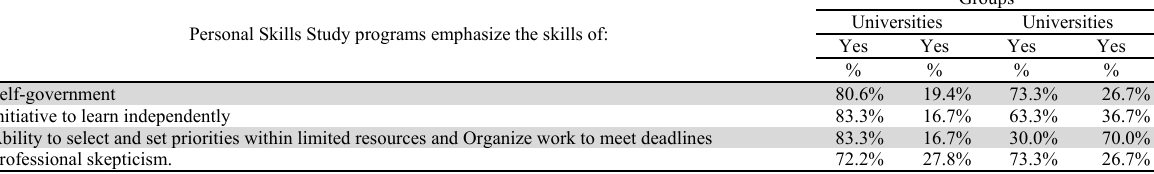
Personal skills study programs emphasize the skills Personal Skills Study programs emphasize the skills of: